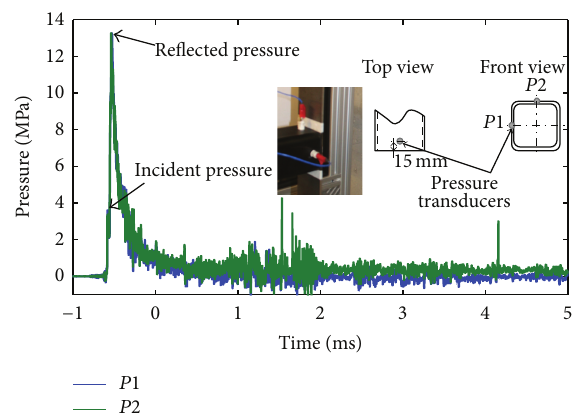
Figure 6: Pressure time signal measured at the tube end by pressure transducers 𝑃1 and 𝑃2 using 10g of C4 set at a stand-off distance of 5 mm from the entrance of the